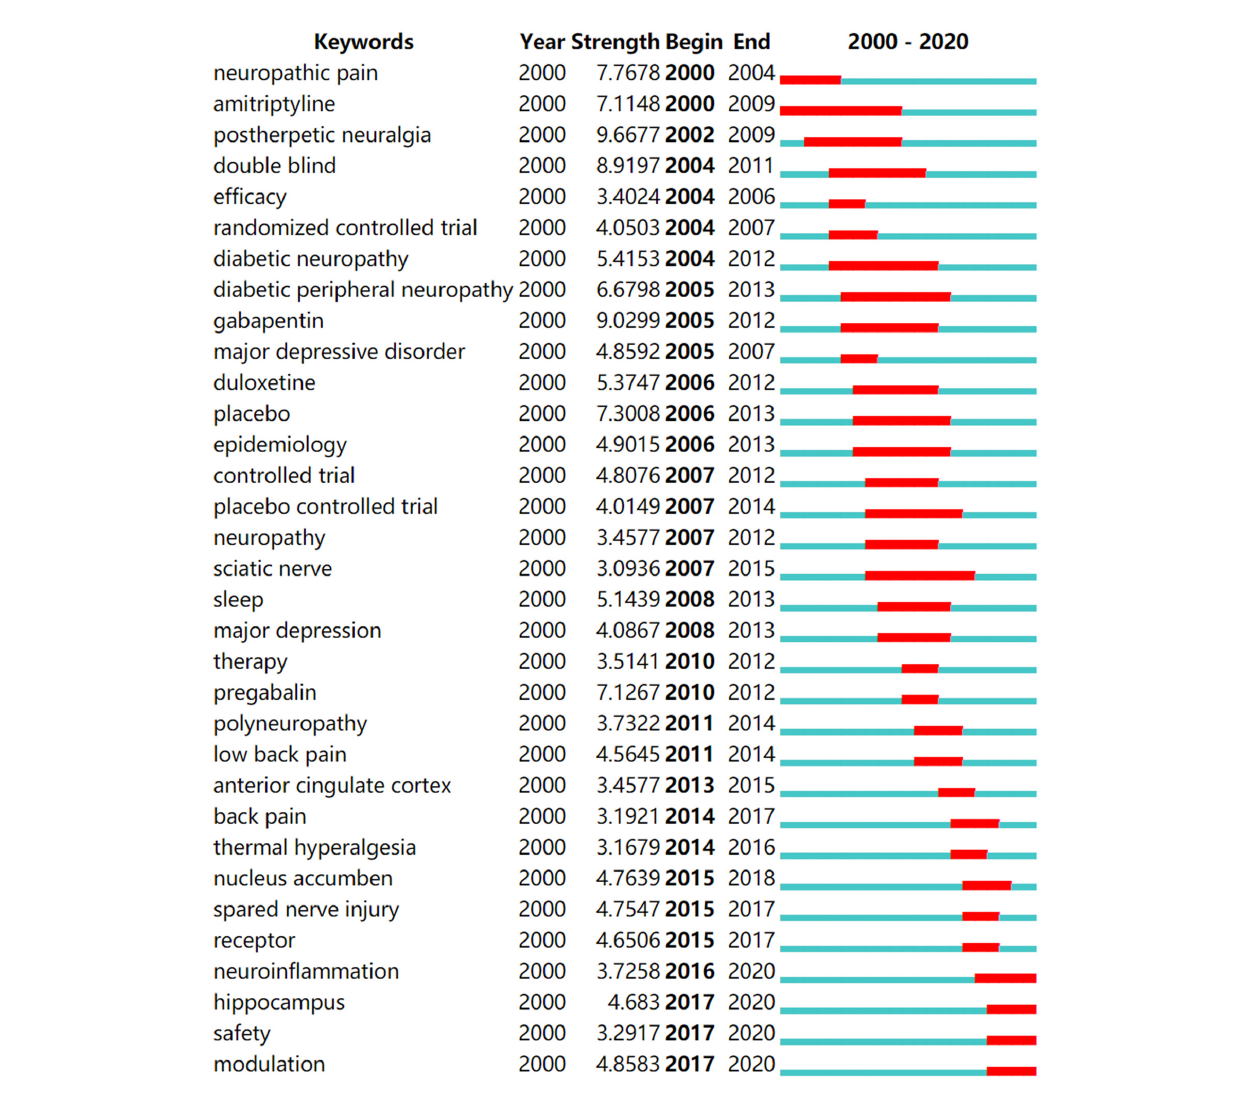
FIGURE 11 | The keywords with the strongest citation bursts of publications on NP associated with anxiety or depression